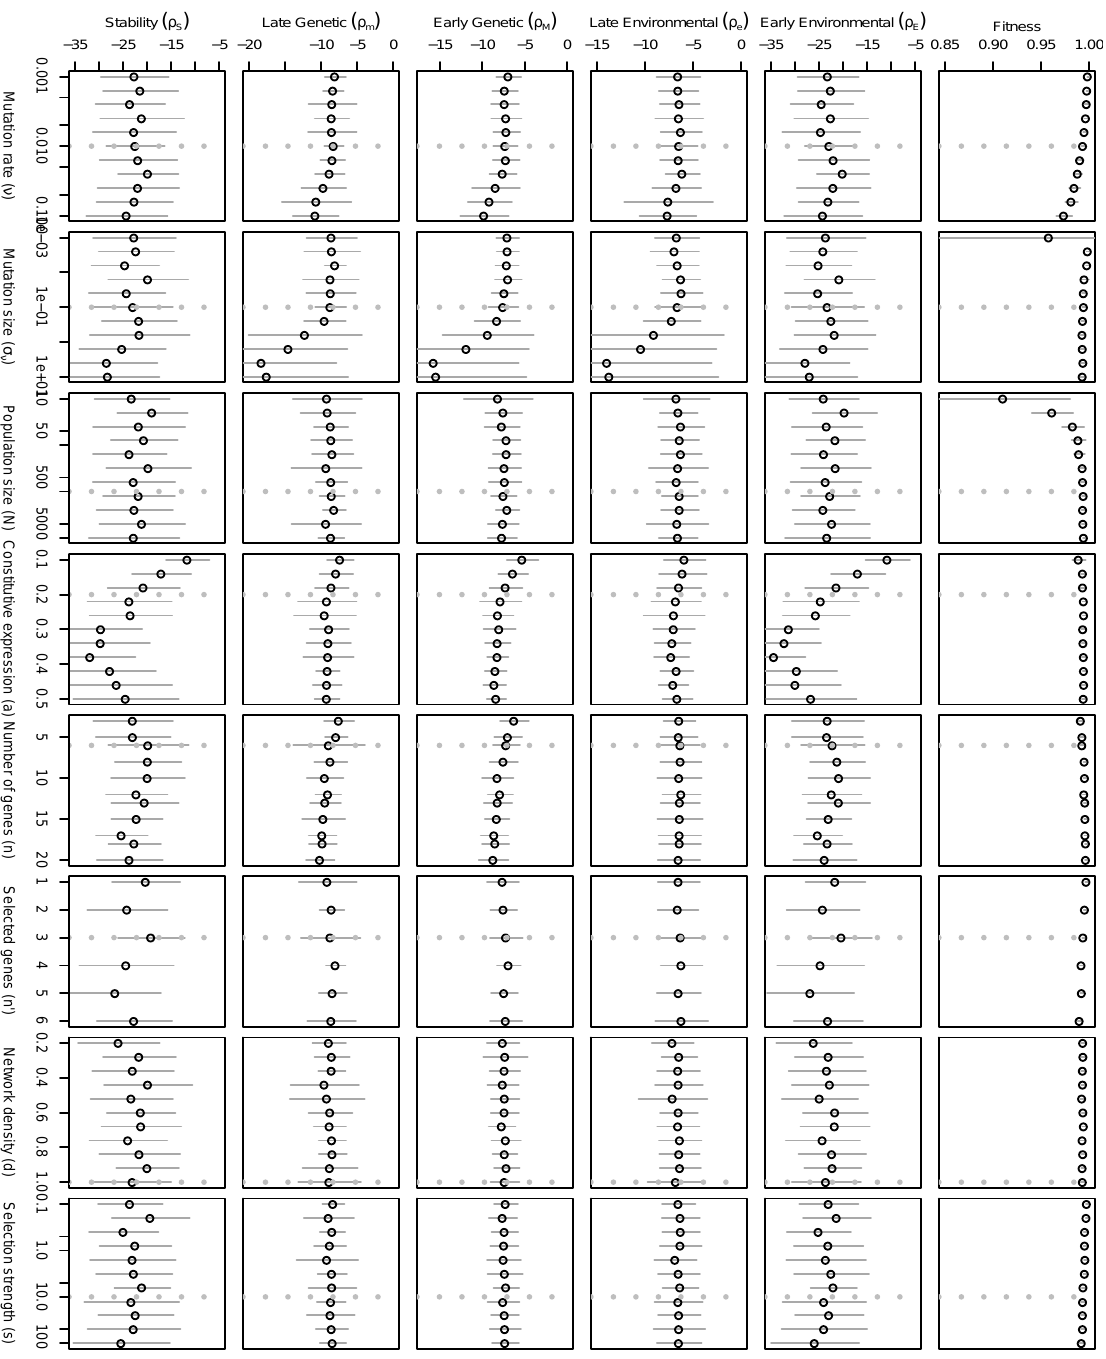
Figure SI7 – Exploration of the parameter set. Influence of simulation parameters (muta- tion rate ν , mutation size σ ν , population size N , constitutive expression a , total number of genes n , number of selected genes n 0 , network density d , and strenght of selection s ) on fitness and robustness indexes after 5000 generations (default settings except for the target parameter). The figure reports the mean standard deviation across 20 replicated ± simulations. Vertical dotted lines stand for the default parameter